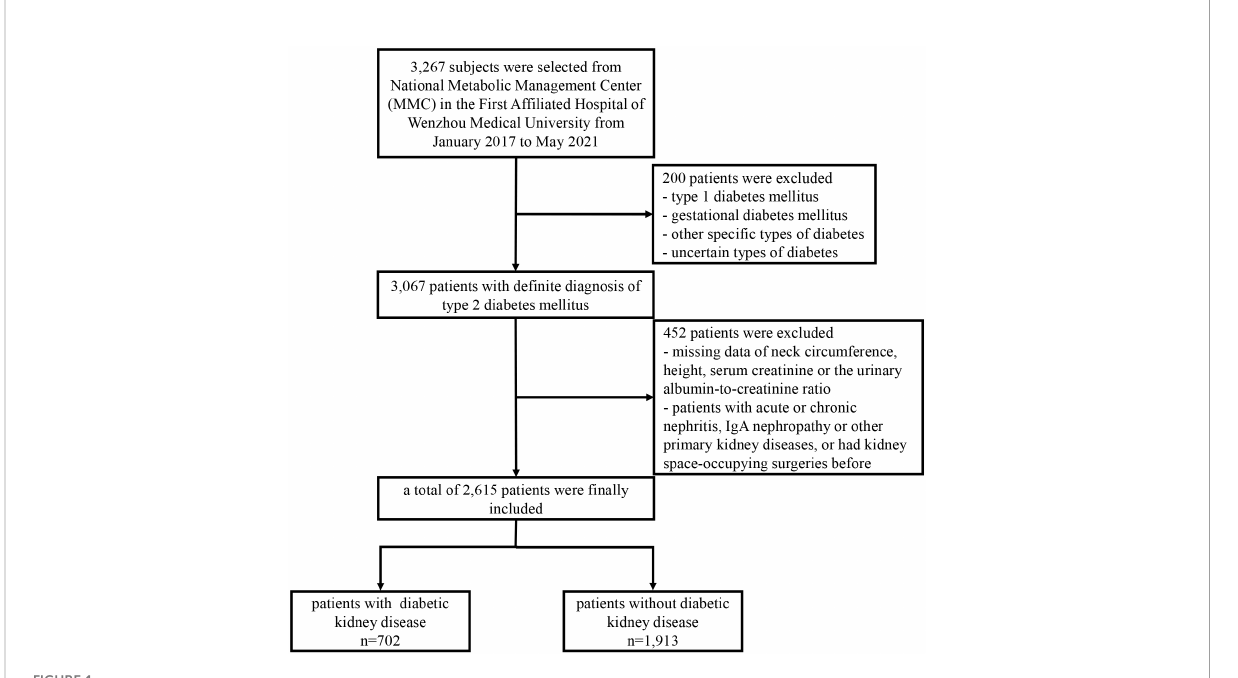
FIGURE 1 Flowchart of study participants